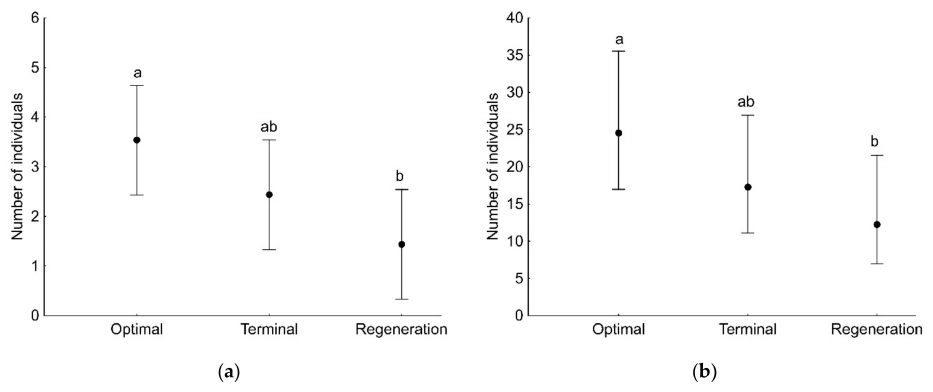
Figure 2. The number of adult ( a ) and juvenile ( b ) spider individuals (mean with 95% confidence limits) recorded on tree branches in a single sample in three developmental phases of primeval oak–lime– hornbeam forest. Different letters indicate significant differences between developmental